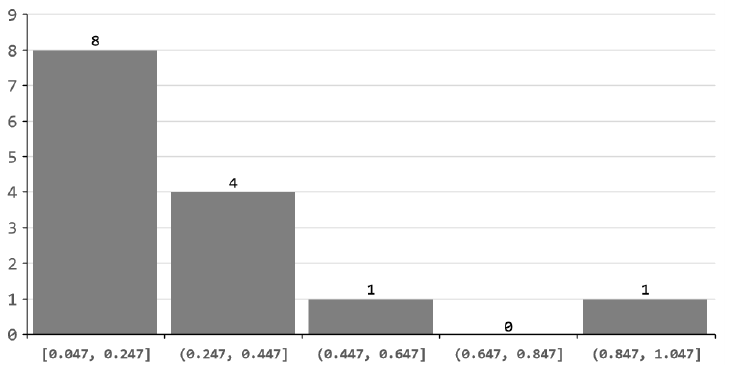
Figure 8. Interval statistical histogram of 𝑃 𝑖 .